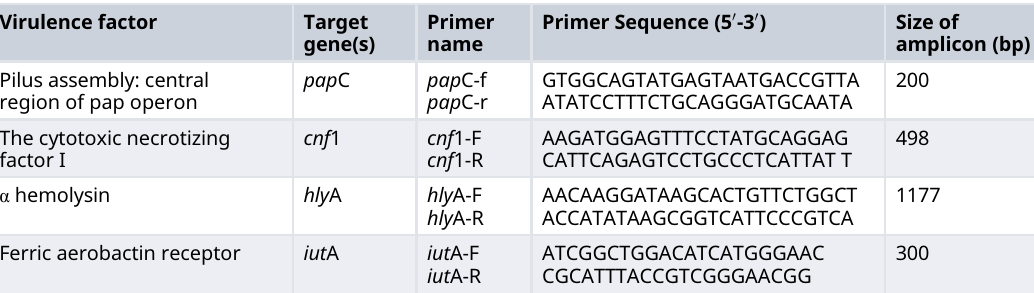
Table 2. Primer sequence of virulence genes in UPEC